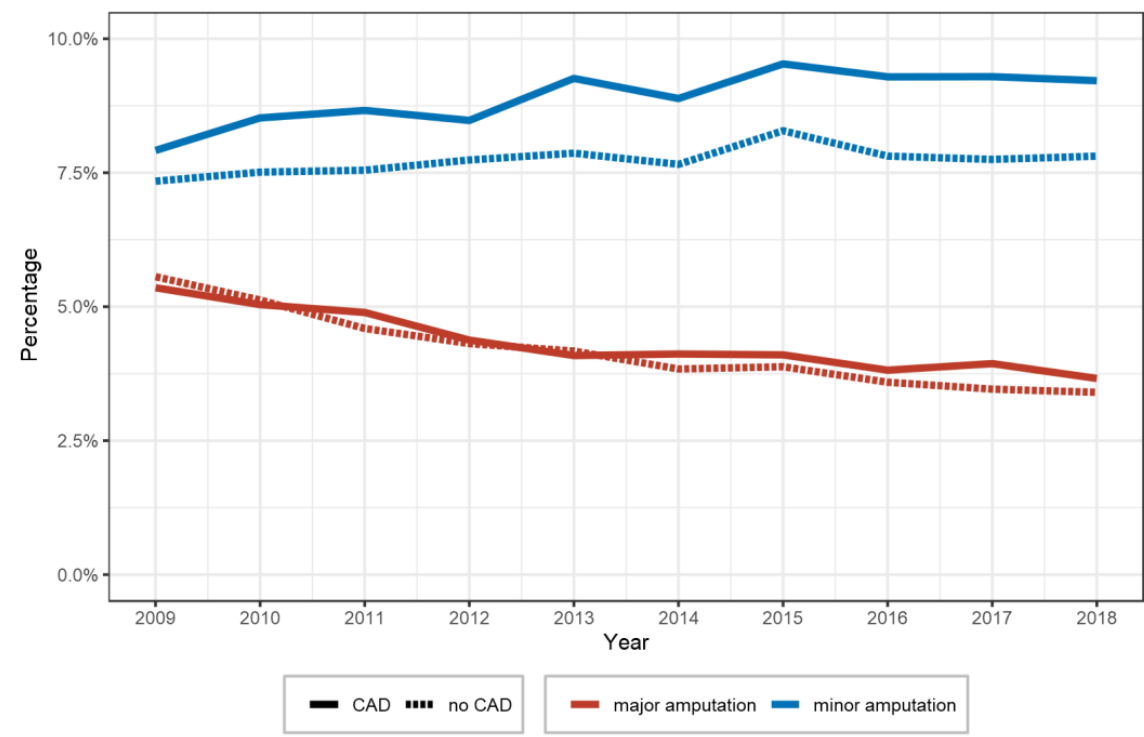
Figure 3. Prevalence of major and minor amputations in patients hospitalized due to peripheral artery disease with and without coronary artery disease between 2009 and 2018.